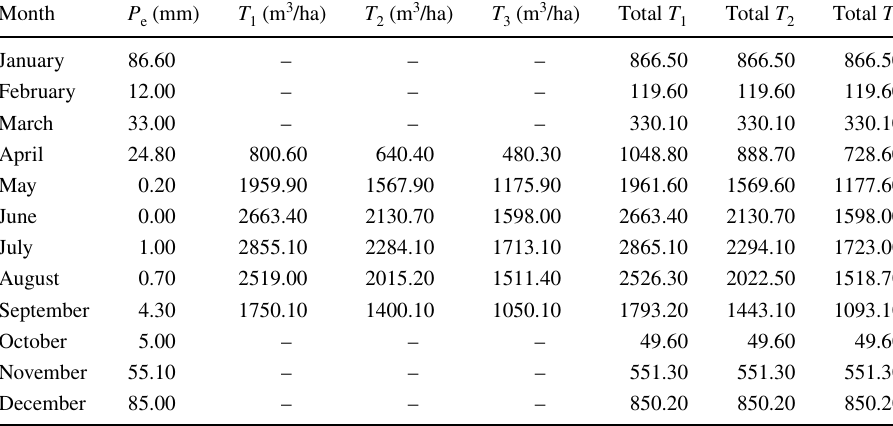
Table 5 Average applied water in experimental